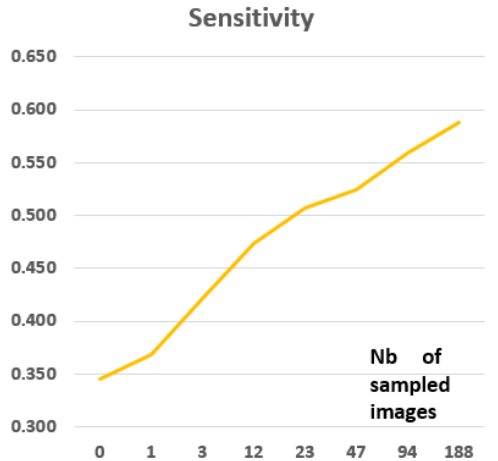
Figure 14. Segmentation sensitivity for different numbers of sampled images from the target domain.